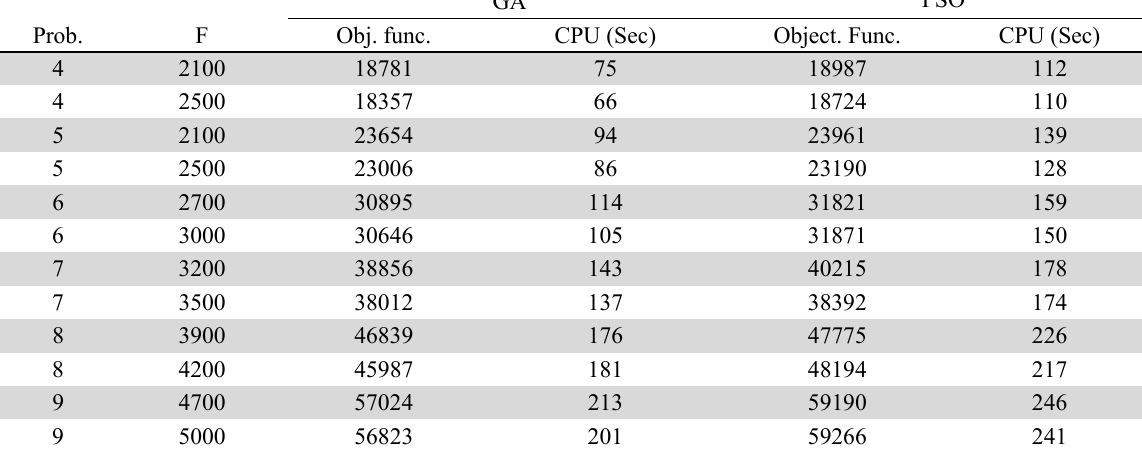
The results of the implementation of GA and PSO for large scale problems GA PSO Prob. F Obj.